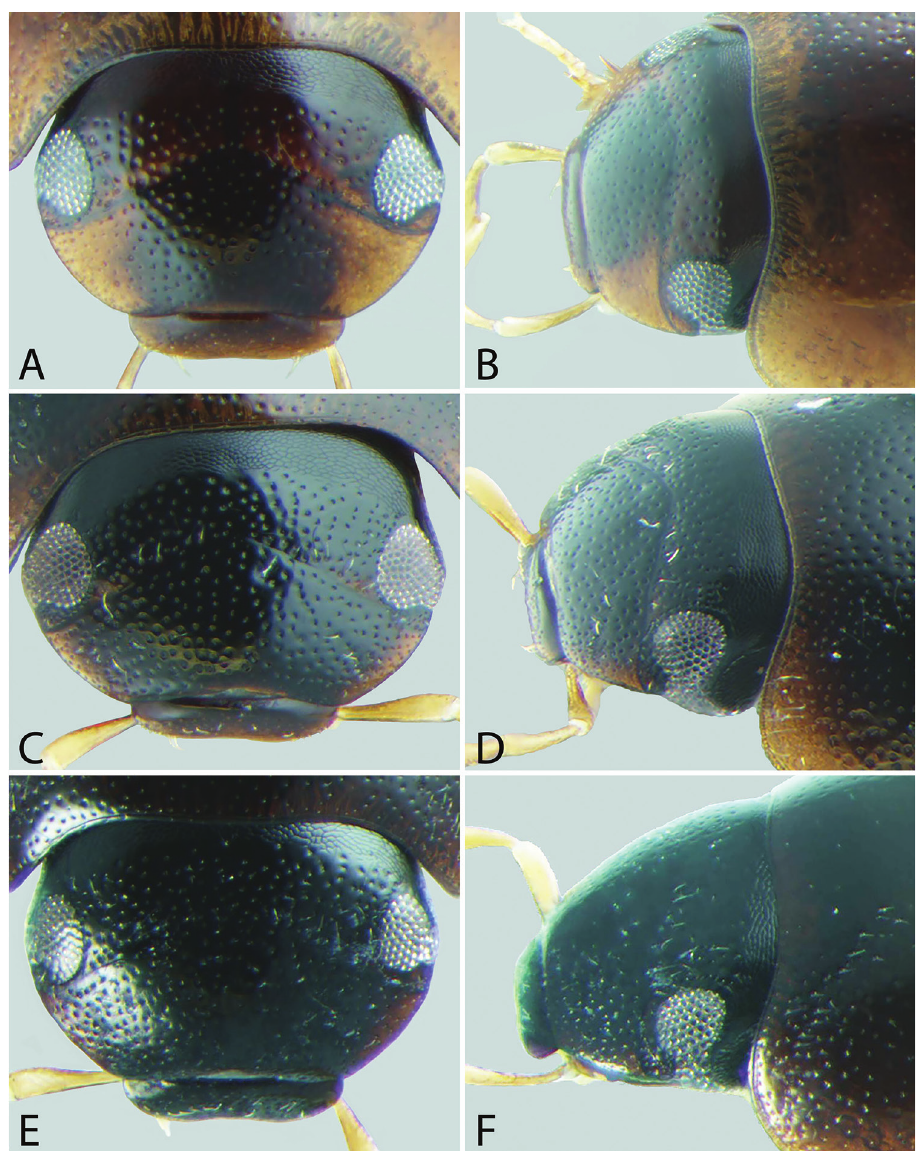
Figure 4. Front and lateral view of heads of Tobochares spp. A–B T. canaliculatus sp. n. C–D T. sipaliwini E–F T. kasikasima Description. Size and form : Body length 1.6–2.0 mm. Body elongate oval, mod- erately dorsoventrally compressed. Color and punctation . Dorsum of head brown to dark brown, anterolateral margins of clypeus with prominent pale preocular patches (Fig. 4A–B); maxillary palps distinctly pale. Pronotum light brown with the lateral margins slightly paler; elytra light brown to brown, slightly paler at lateral margins and